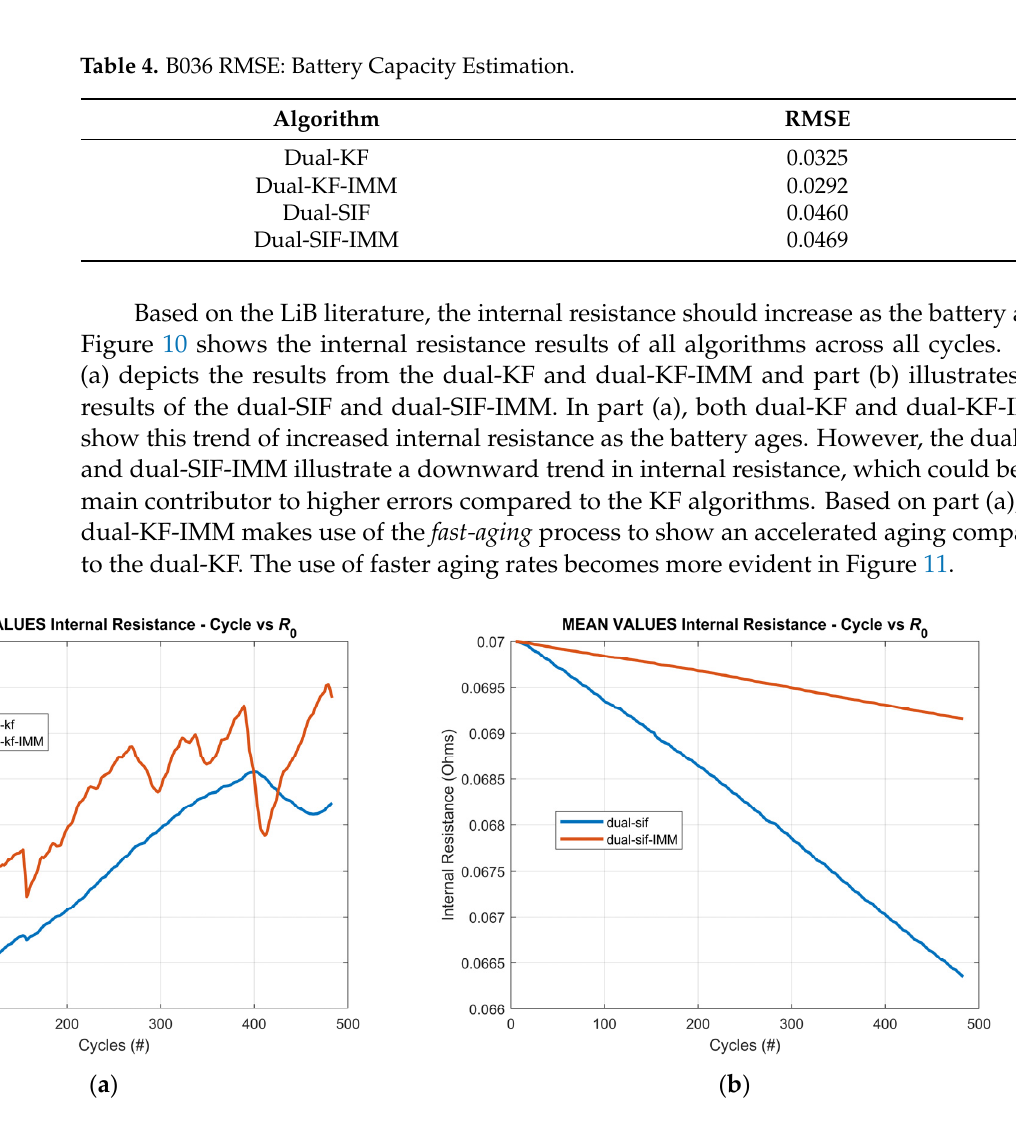
Figure 10. ( a ) Dual-KF and dual-KF-IMM internal resistance estimates. ( b ) Dual-SIF and dual-SIF- IMM internal resistance estimates.